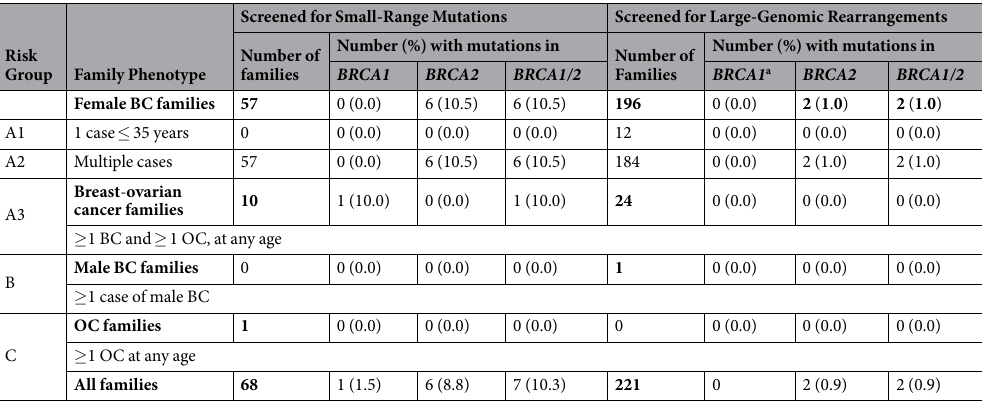
Table 1. Distribution of examined families in high-risk groups and corresponding BRCA1/2 mutation frequencies. BC, breast cancer; OC, ovarian cancer. a 72/221 breast/ovarian cancer families were screened for BRCA1